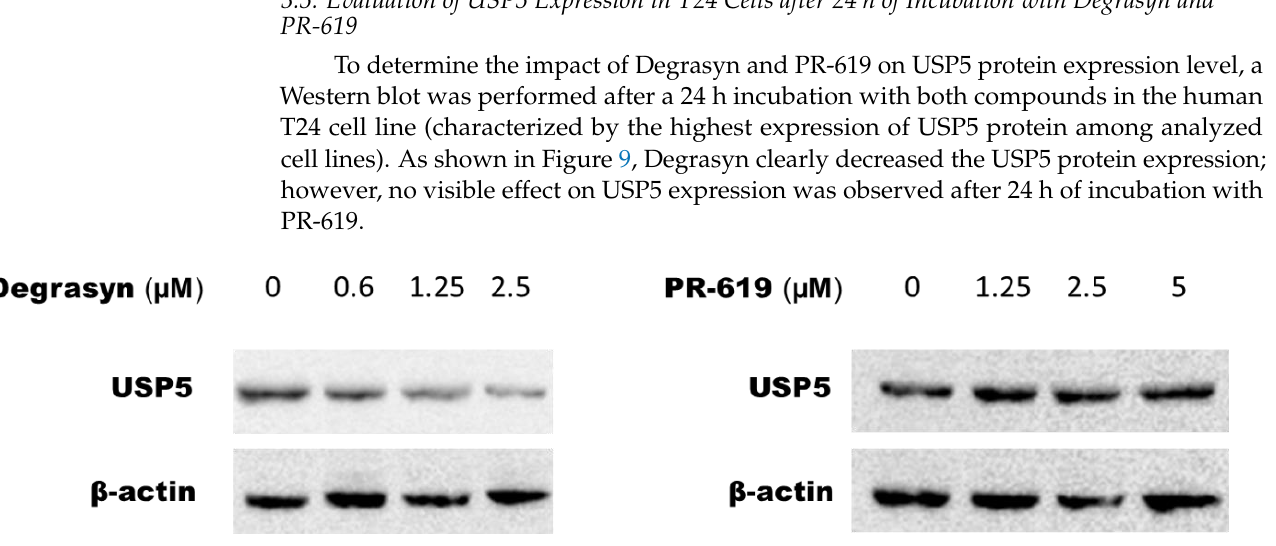
Figure 9. Western blot analysis for USP5 expression in T24 cells after 24 h of incubation with increasing concentrations of Degrasyn (0.6, 1.25, and 2.5 μM) and PR - 619 (1.25, 2.5, and 5 μM). USP = ubiquitin-specific protease.